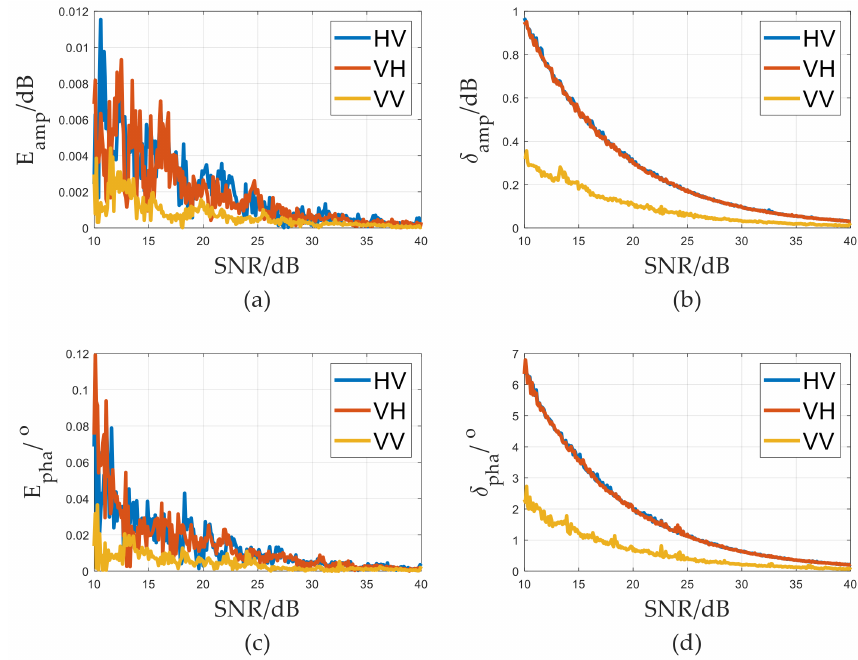
Figure 3. Relationships between SNRs and expectation, E, and standard deviation, δ , of the amplitude and phase errors of different polarization elements for PCTAR. ( a ) Expectations, E amp , of amplitude errors; ( b ) standard deviations, δ amp , of amplitude errors; ( c ) expectations, E pha , of phase errors; ( d ) standard deviations, δ pha , of phase